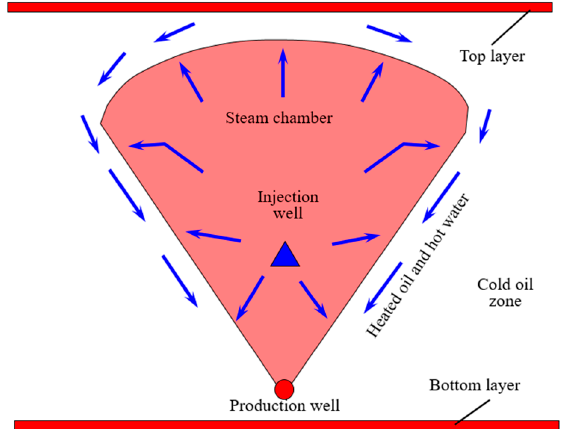
Figure 2. Development process of SAGD steam cavity in heavy-oil reservoir.